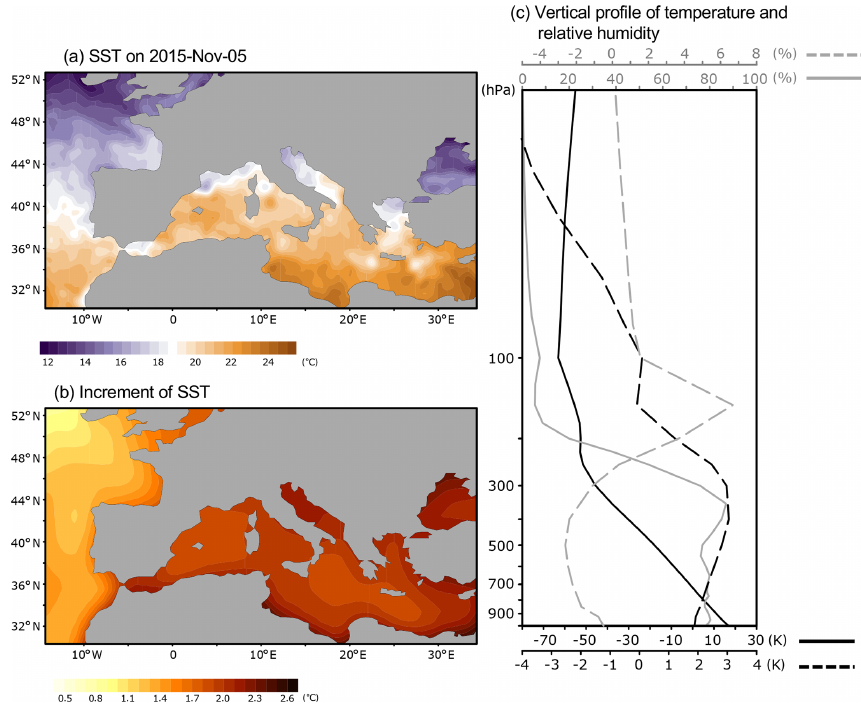
Figure 2. (a) Sea surface temperature (SST) at 00:00UTC on 5 November 2011 in OISST in WRF first domain. Increment projected by 18 CMIP5 CGCMs (b) SST in the WRF first domain and (c) vertical profiles of increments of air temperature and relative humidity averaged over WRF’s second domain between 2035–2065 and 1975–2006. Table 1. CMIP5 GCMs used for deriving the climate perturbations for the PGW